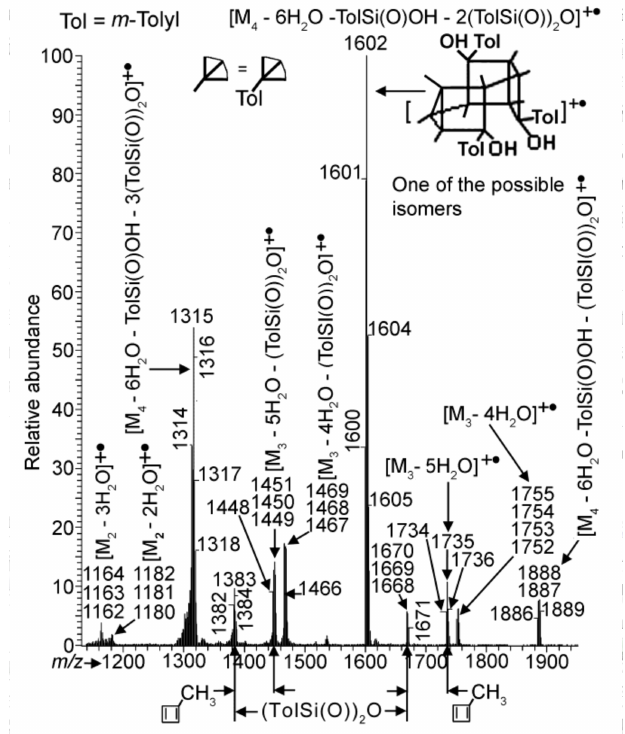
Figure 5. PI APCI mass spectrum of the products obtained after heating of a toluene solution of 1 at atmospheric pressure at 110 ◦ C in a molybdenum glass flask in the presence of MMT for 120 min (product 5